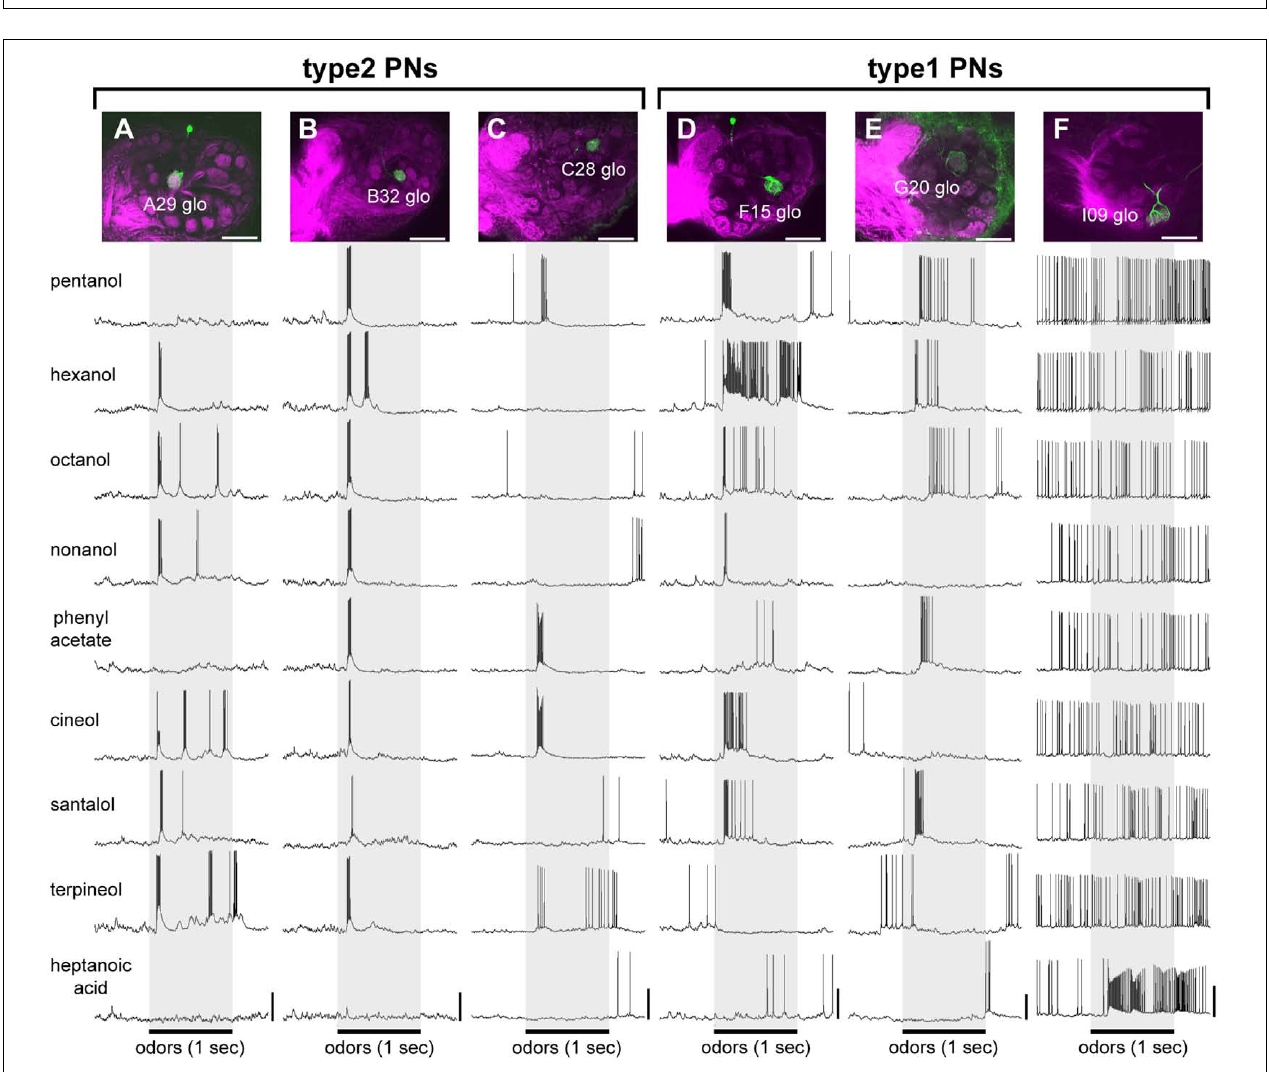
FIGURE 4 | Typical olfactory responses of two different types of PNs. (A–F) Olfactory responses of three type2 PNs (A–C) and three type1 PNs (D–F) . Each of the recorded PNs (green) has its dendrites in a single glomerulus (magenta) belonging to different glomerular groups [laser scanning microscope (LSM) images in A–F ]. During intracellular recording, nine odors were presented to the antenna. The 1-s olfactory stimuli are indicated by gray boxes. White bars in LSM images = 100 µ m; vertical bars = 20